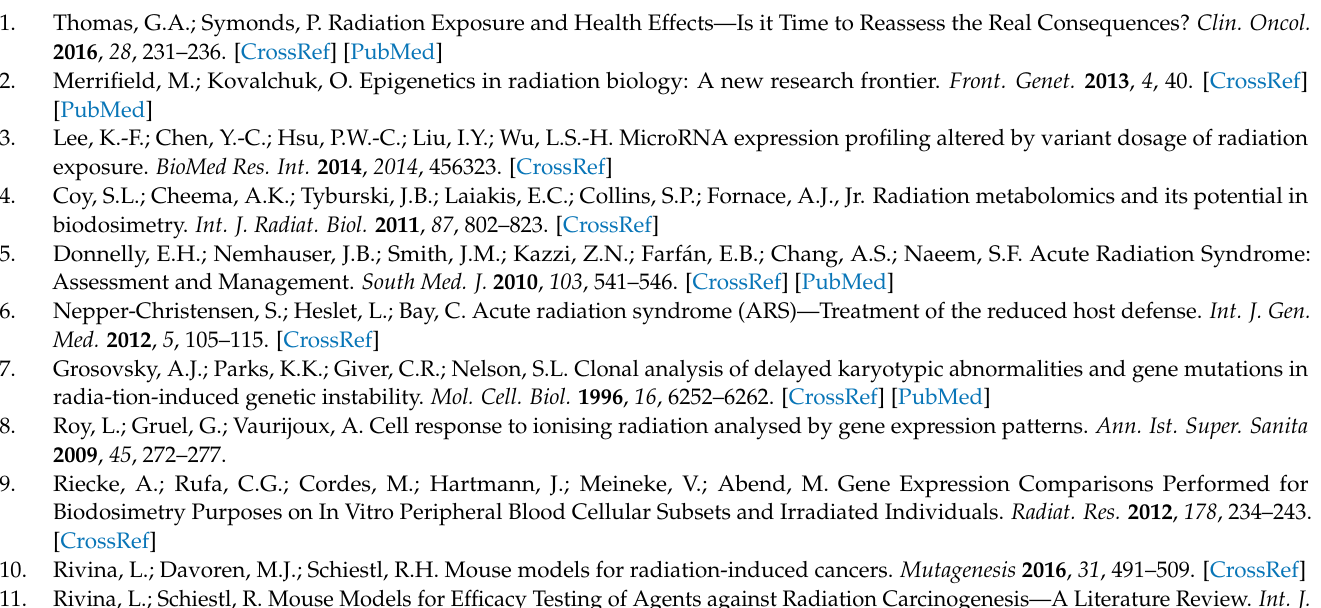
Figure S1: Significantly (Abs z-score ≥ 2 and -log p ≥ 1.3) modulated pathways in at least one time point from the analysis of SDTGs ( p ≤ 0.05 and Abs FC ≥ 2) at h2, d4, and d7 TPs in lethal (20Gy) and sublethal IR doses (1, 3, 6Gy). Color of squares ranges according to modulation intensity from dark blue for inactivation to dark red for activation prediction based on z-score